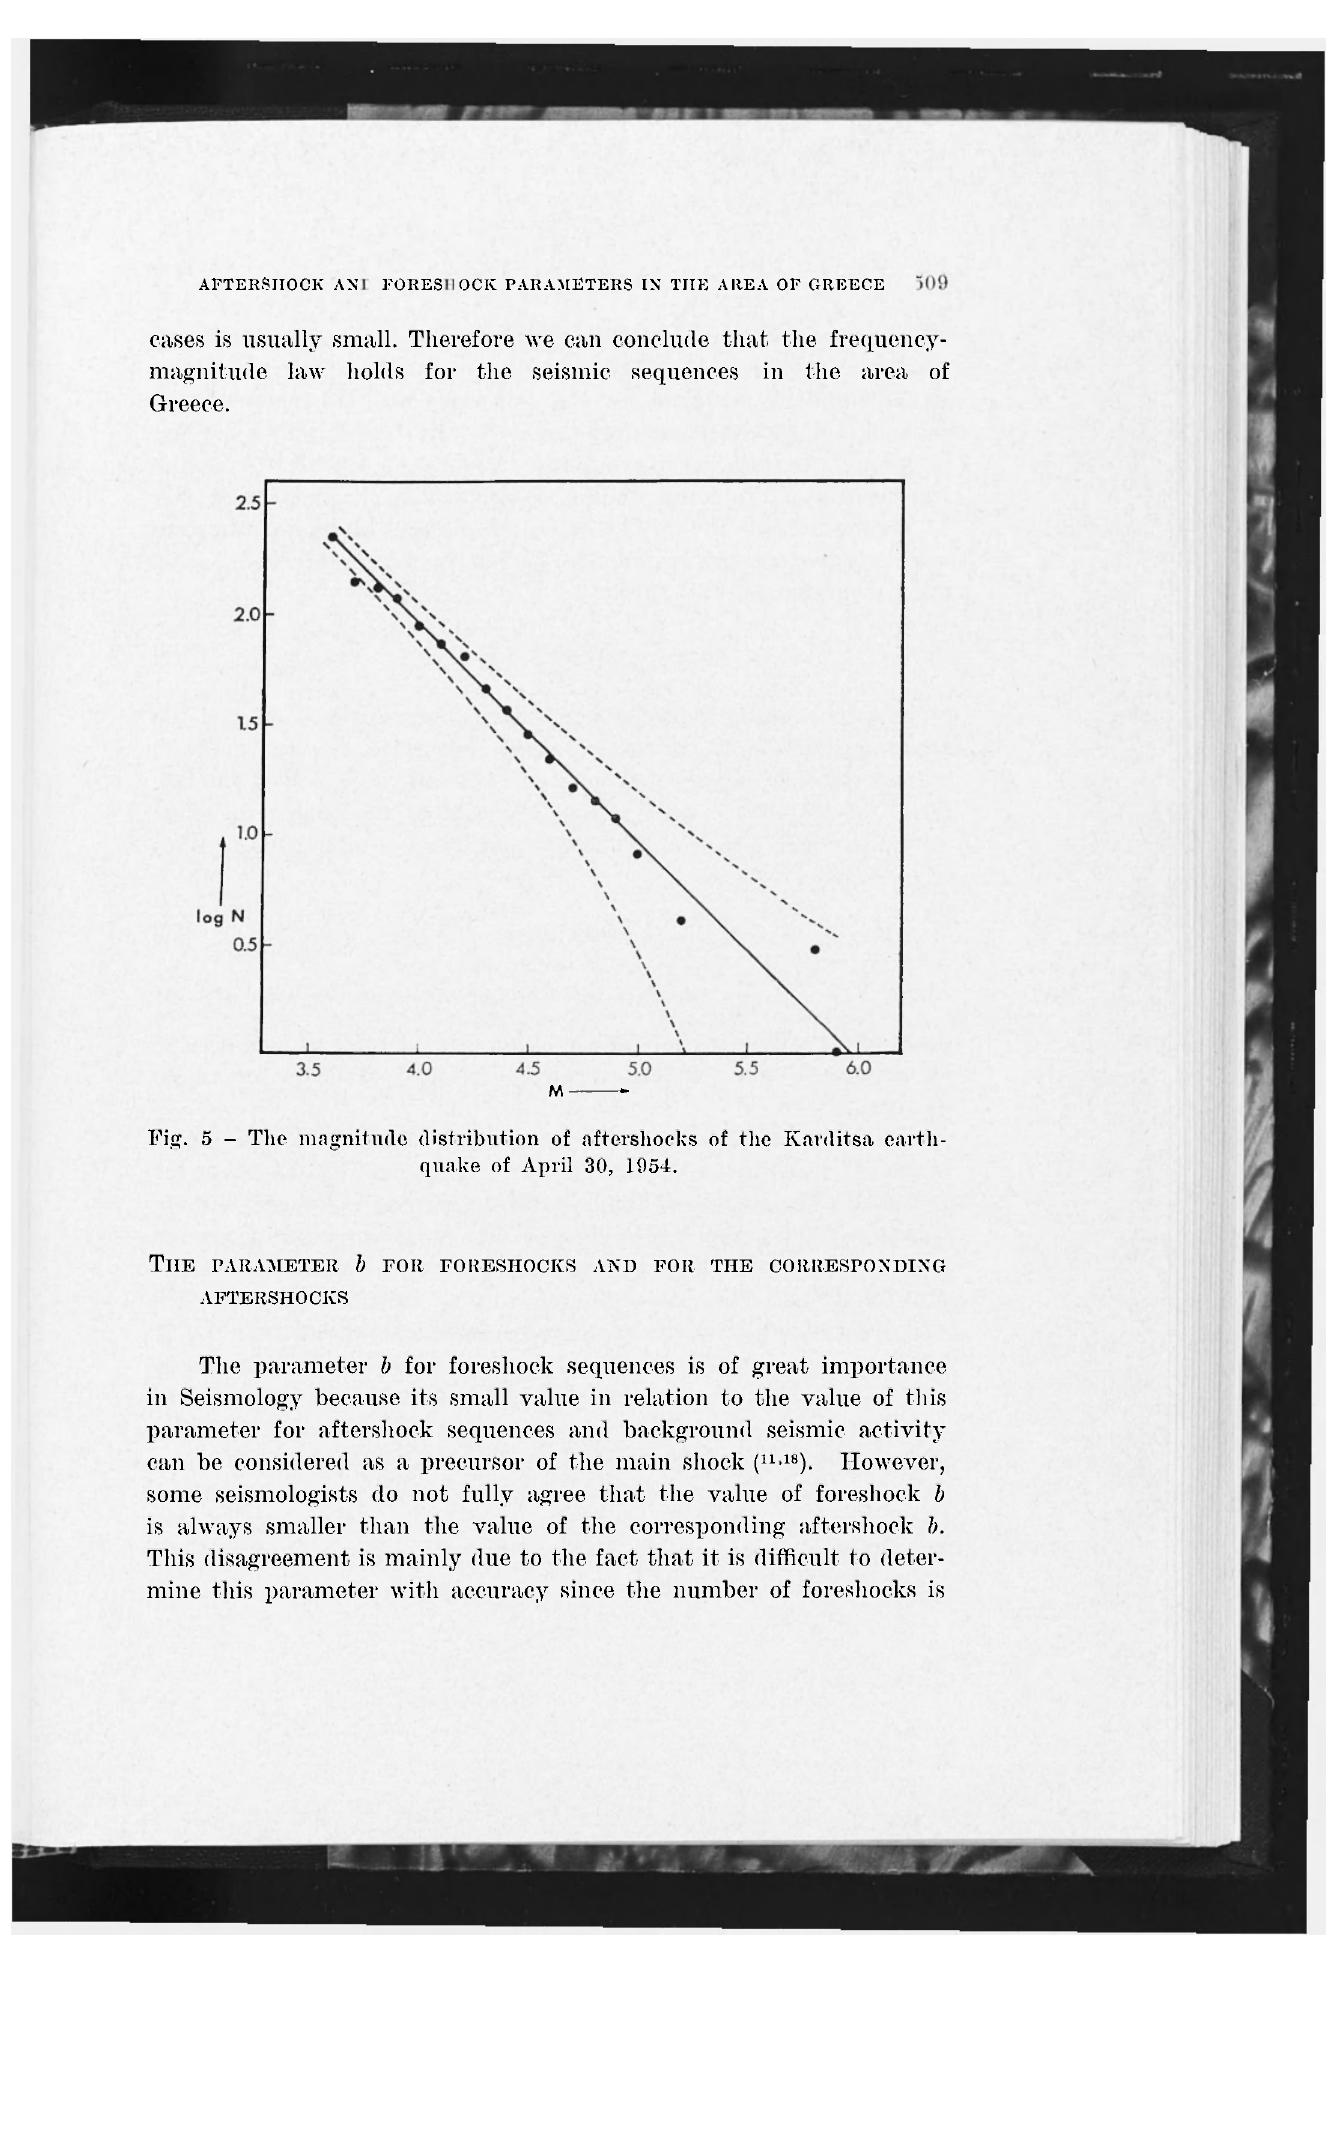
Fig. 5 - The magnitude distribution of aftershocks of the Karriitsa earth- quake of April 30,